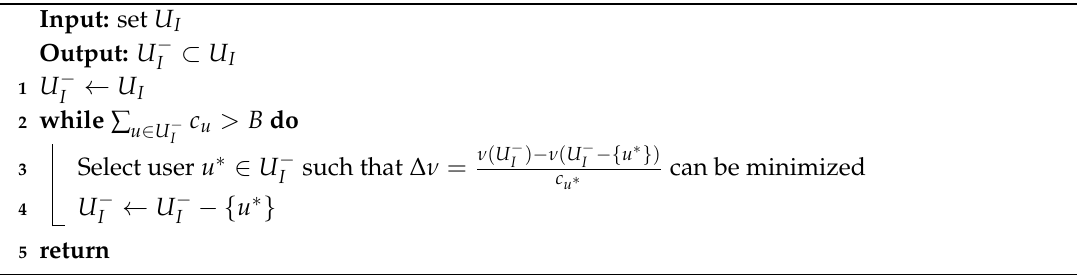
Algorithm 1: Deleting Users in the Case of Budget Overrun.